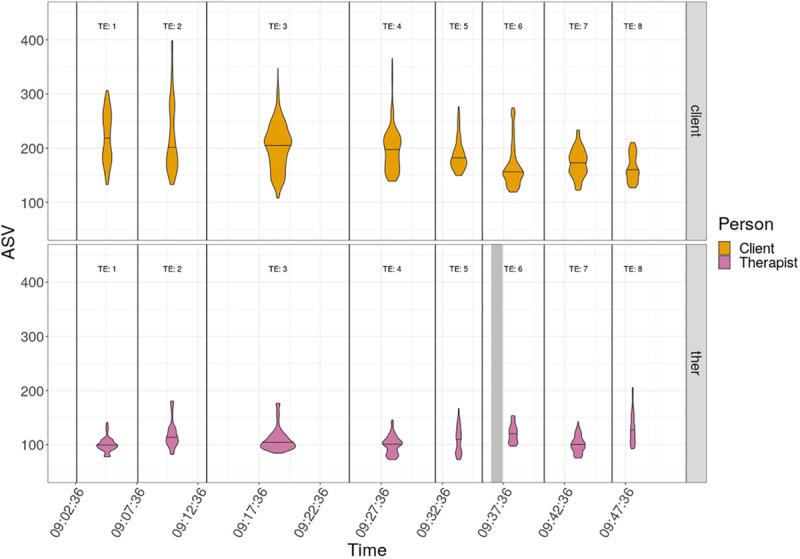
Violin plot of ASV of client and therapist by Topical Episodes. Separate violin plots of ASV are positioned on the midpoints of the TEs for the client and therapist. A violin plot gives a picture of the distribution of values. The areas of the “violins” are proportionate to the number of values hence the larger violins for the longer TEs and the larger violin for the client than the therapist for TE 6, which has the missing therapist ASV values. The violins stretch from the minimum to the maximum ASV value per person per TE and the horizontal waist lines on the violins mark the median scores for the person and TE. The widths of the violins show the actual distribution of values (which are marked on the y-axis).